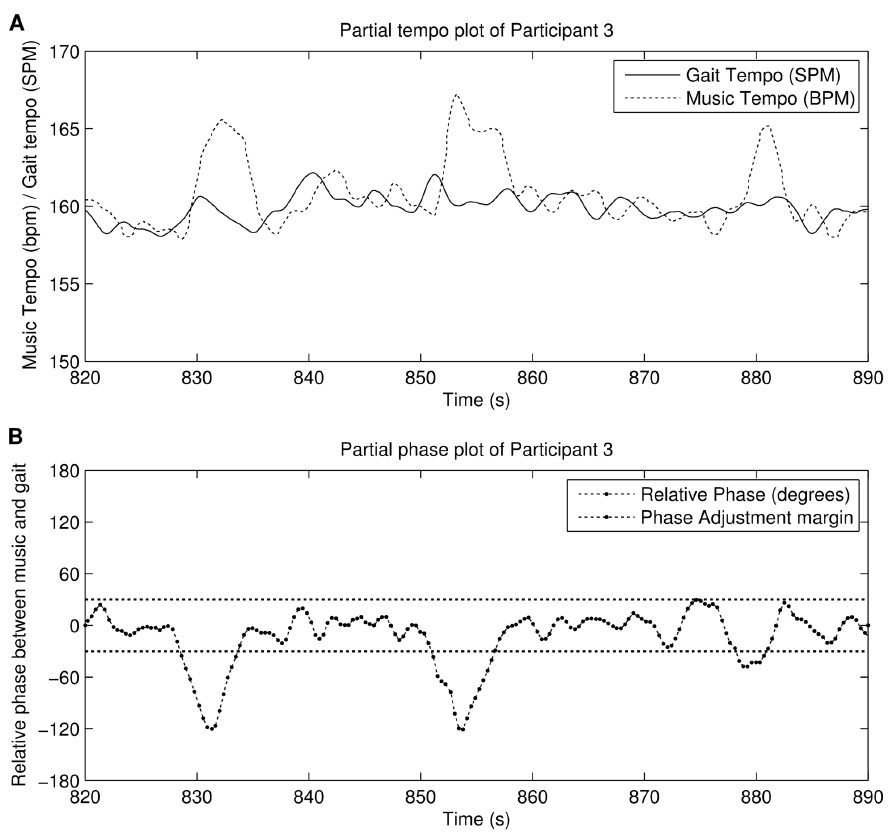
Fig. 13. Excerpt from one participant during the experiment using alignment strategy 4 (tempo- adaptive phase-adaptive). Figure A shows the tempo plots, where the tempo adaptation from the algorithm is clearly visible. Figure B shows the relative